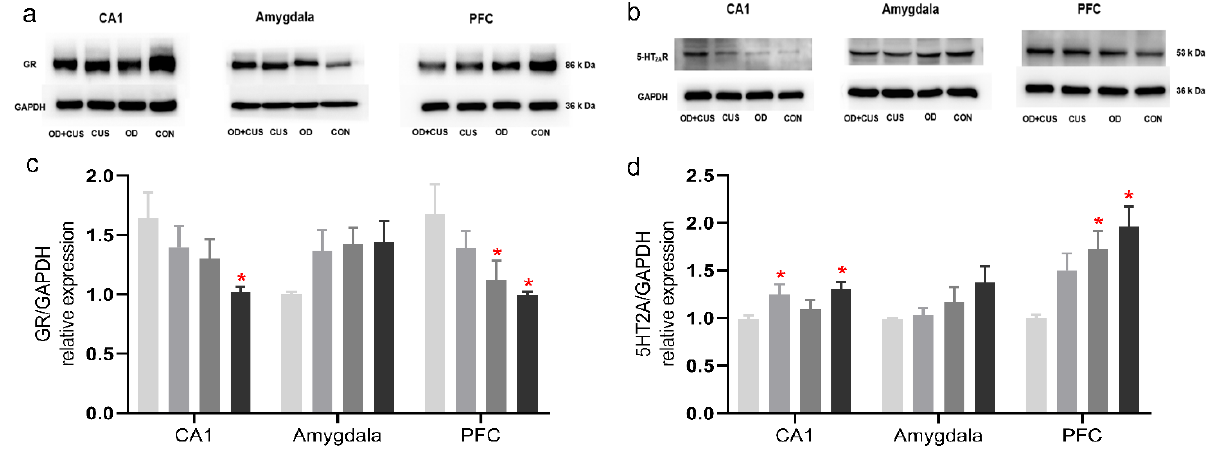
Figure 3. Analysis of GR and 5-HT 2A R expression in the hippocampal CA1, amygdala and PFC on day 56. ( a ) Western blot for GR protein expression in the OD + CUS, CUS, OD and CON groups. ( a ) Western blot for 5-HT 2A R protein expression in the OD + CUS, CUS, OD and CON groups. ( c ) Statistical comparison of the blotting data for GR protein levels. ( d ) Statistical comparison of the blotting data for 5-HT 2A R protein levels. Data are shown as the mean ± SEM. * p < 0.05, compared with the CON group.